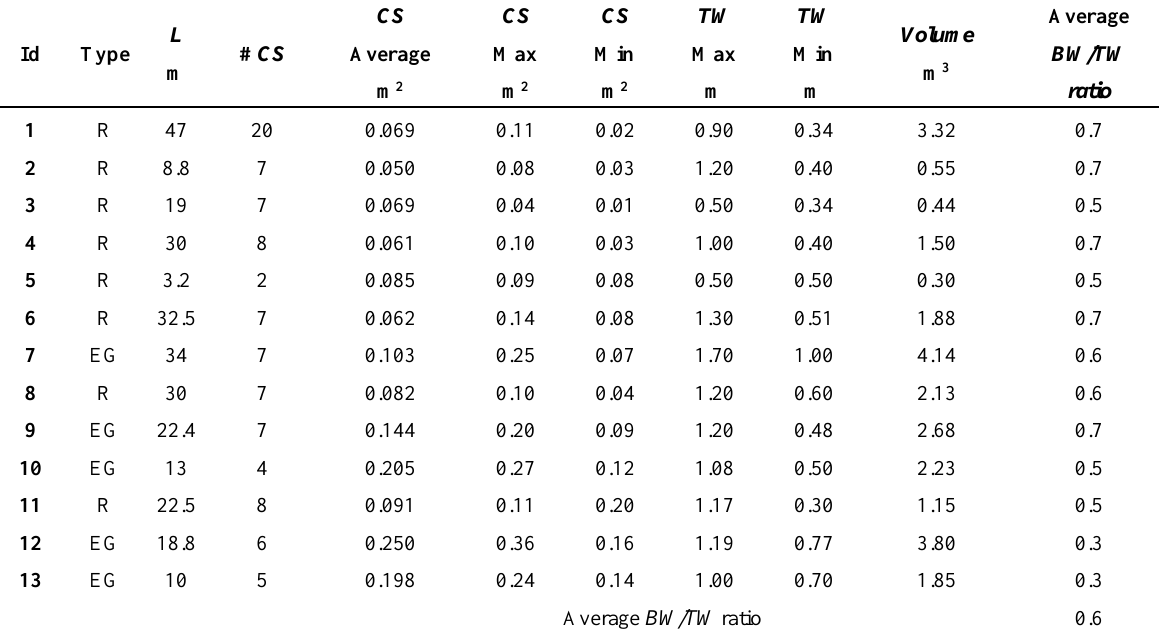
Table 3. Measurements of the rills and ephemeral gullies that were surveyed in the field.